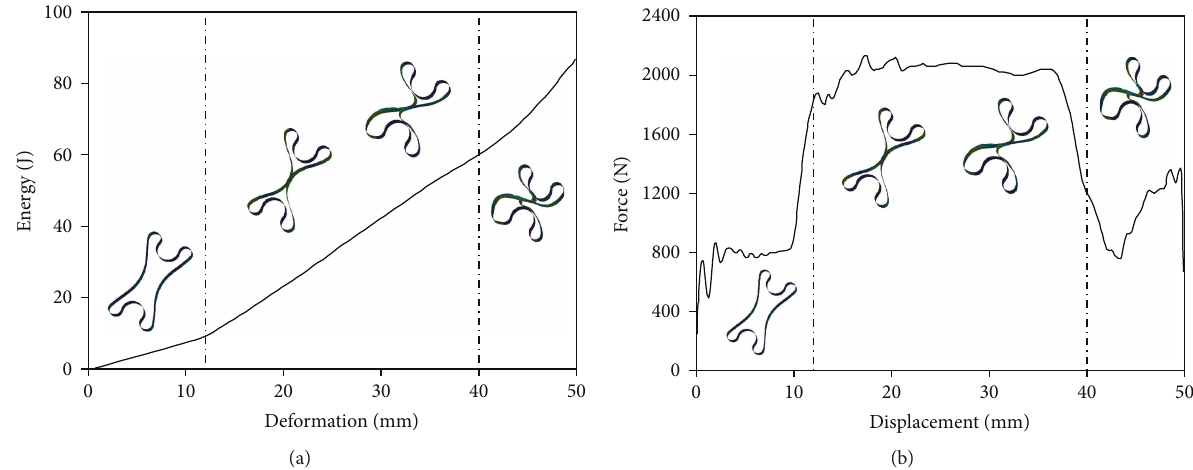
Figure 2: Energy deformation and load deformation curves of X-shaped absorber unit under compression.